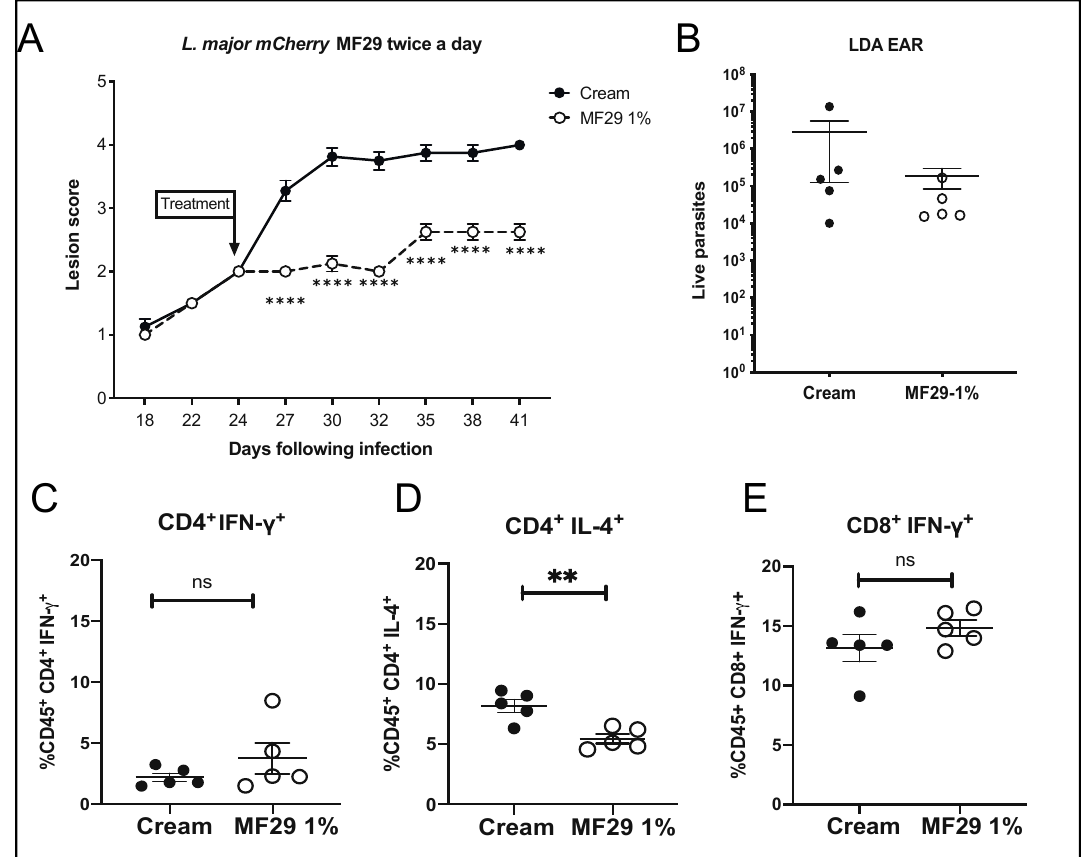
Figure 4. Topical application of MF29 1% twice per day. BALB/c mice were infected i.d. with metacyclic L. major LV39 promastigotes and ears were either treated twice daily with vehicle cream or MF29 1% cream once the lesion score reached 2. ( A ) Lesion development, data are mean ± SEM, Two-Way ANOVA (Bonferroni’s post-hoc test) ** p < 0.005, ns = not significant. ( B ) Forty-one days after infection, the parasite load in the infected ear was determined by limiting dilution assay (LDA). ( C ) The frequency of CD4 + INF- γ + , ( D ) CD4 + IL-4 + and ( E ) CD8 + IFN- γ + was determined by flow cytometry in the dLN. Data are represented as mean ± SEM, non-parametric T-test (Mann–Whitney U -test) ** p < 0.07, ns = not significant. The data are representative of two experiments including 5 mice/group.